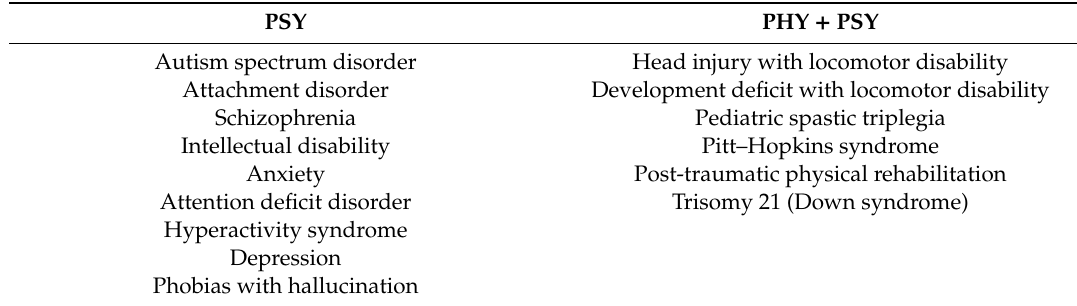
Table 1. Disorders diagnosed in the included